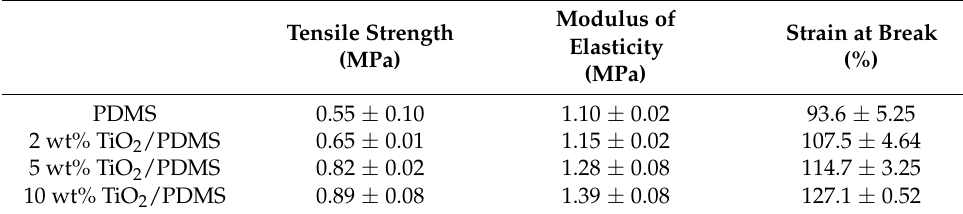
Table 3. Tensile test results of PDMS and TiO 2 /PDMS nanocomposites.